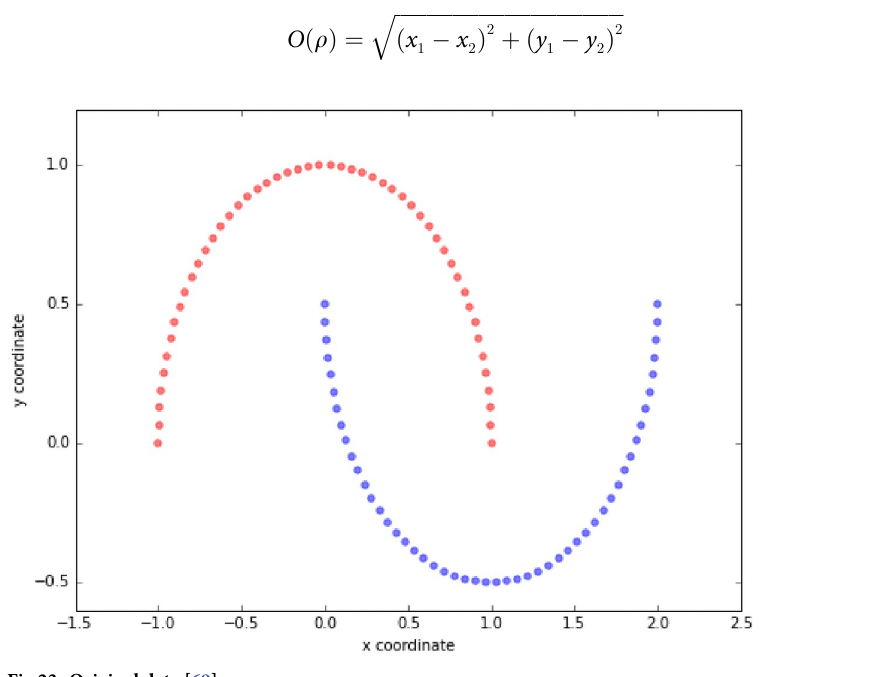
Fig 23. Original data